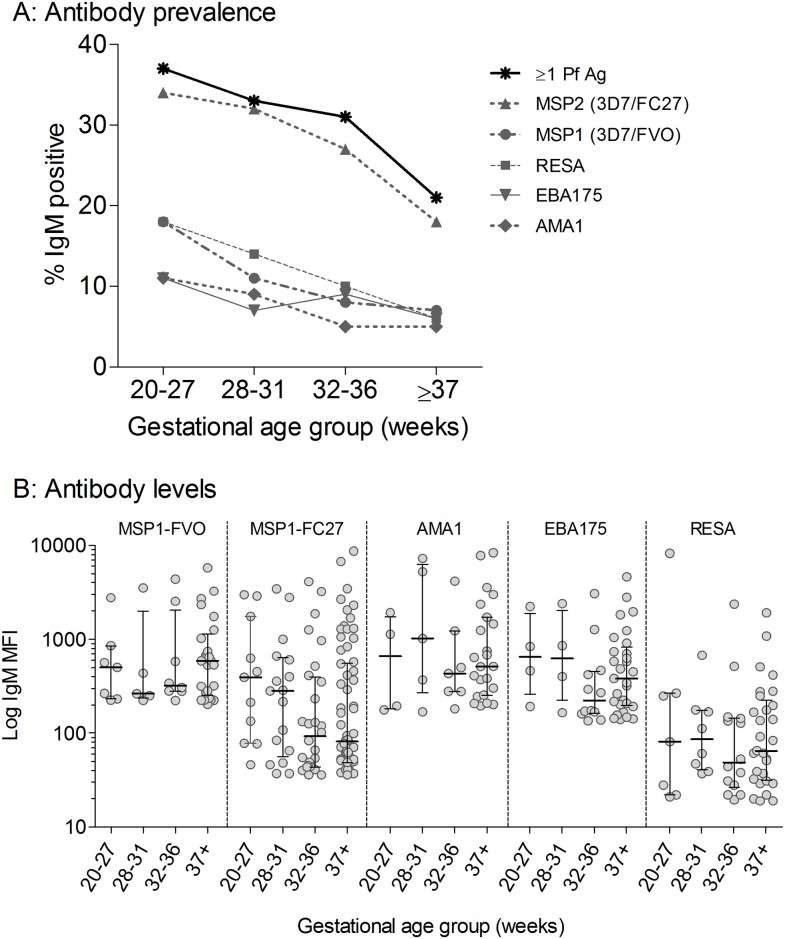
Timing of the prenatal Pf IgM response.(A) The percent of newborns (n = 682) positive for IgM to Pf Ags was stratified by gestational age category. The proportion of IgM+ newborns decreased with gestational age, Chi-square test for trend: MSP1 (i.e., positive for IgM to the 3D7 or FVO variant of MSP1), p = 0.008; MSP2 (3D7 or FC27), p = 0.0006; AMA1, ns; EBA175, ns; RESA, p = 0.002; and ≥1 Pf Ag, p = 0.001. For clarity of figures, confidence intervals of proportions are provided in the text but not on the figure. (B) Amount of IgM Ab present for newborns who were Ab positive for the specified antigen. Average IgM levels did not differ significantly with GA for any of the antigens (Kruskal-Wallis).